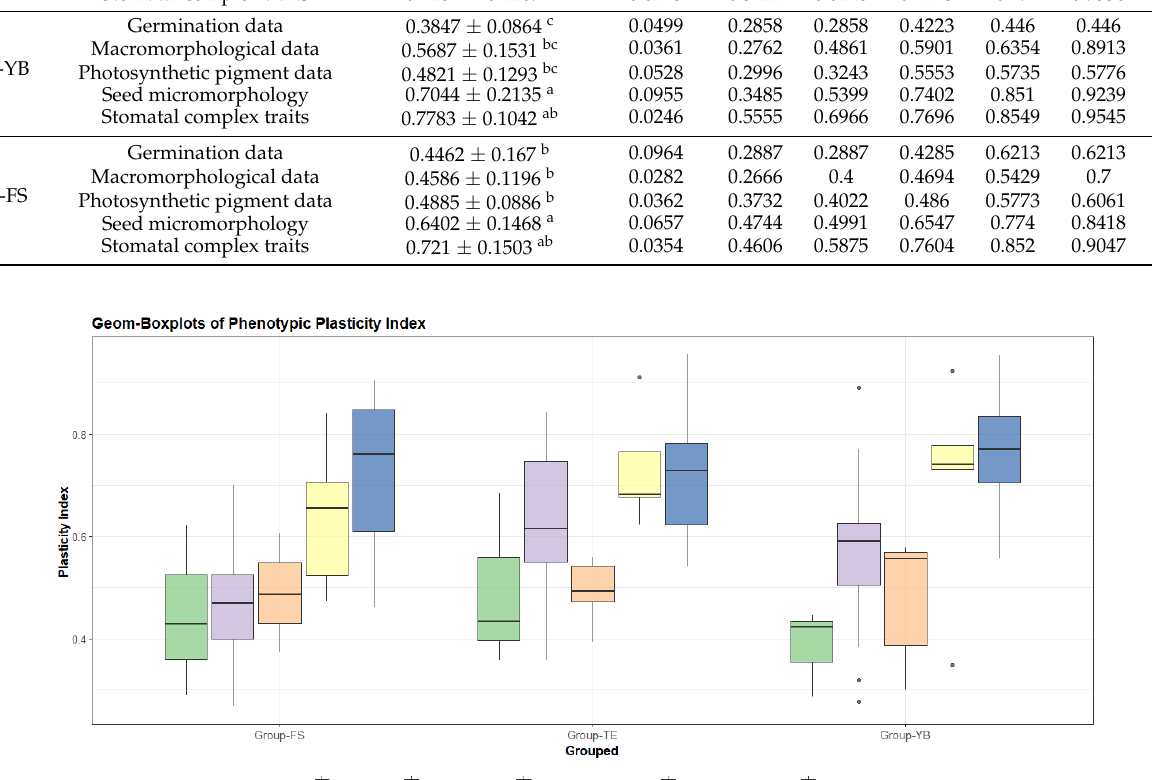
Figure 7. Boxplots showing phenotypic plasticity index (PI) distribution for each of the measured traits among the three identified groups.